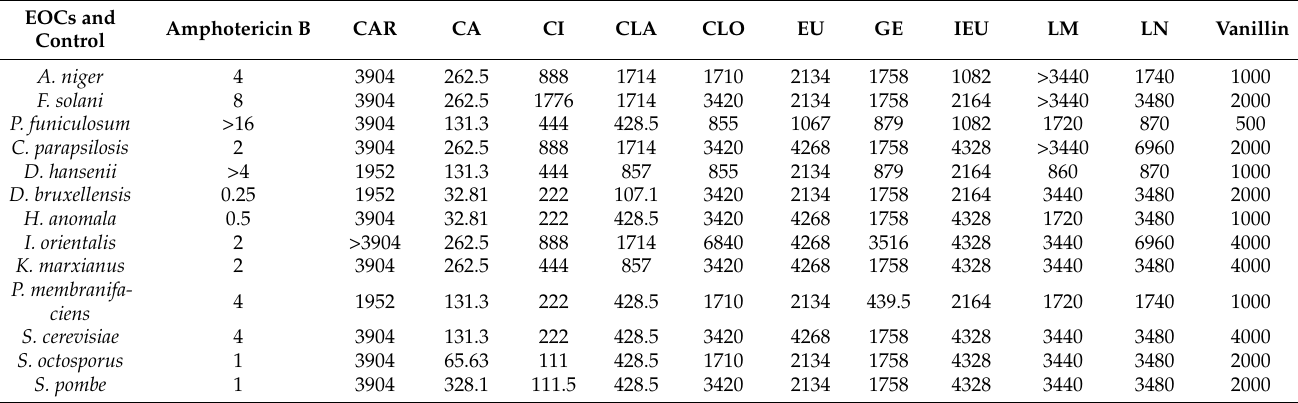
Table 1. Minimal inhibitory concentration (MIC) of tested EOCs against yeast and mold strains as mean of independent biological triplicate measurements ( n =